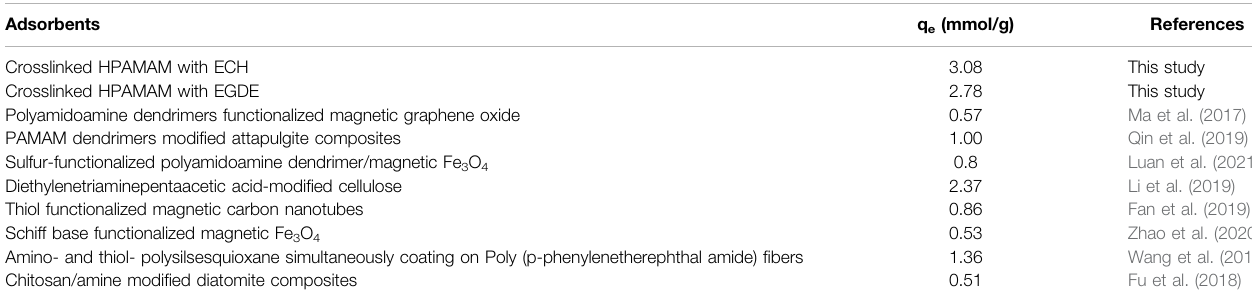
TABLE 6 | Comparison of adsorption capacity of different adsorbents for Hg(II) at 25 ° C. Adsorbents q e (mmol/g)